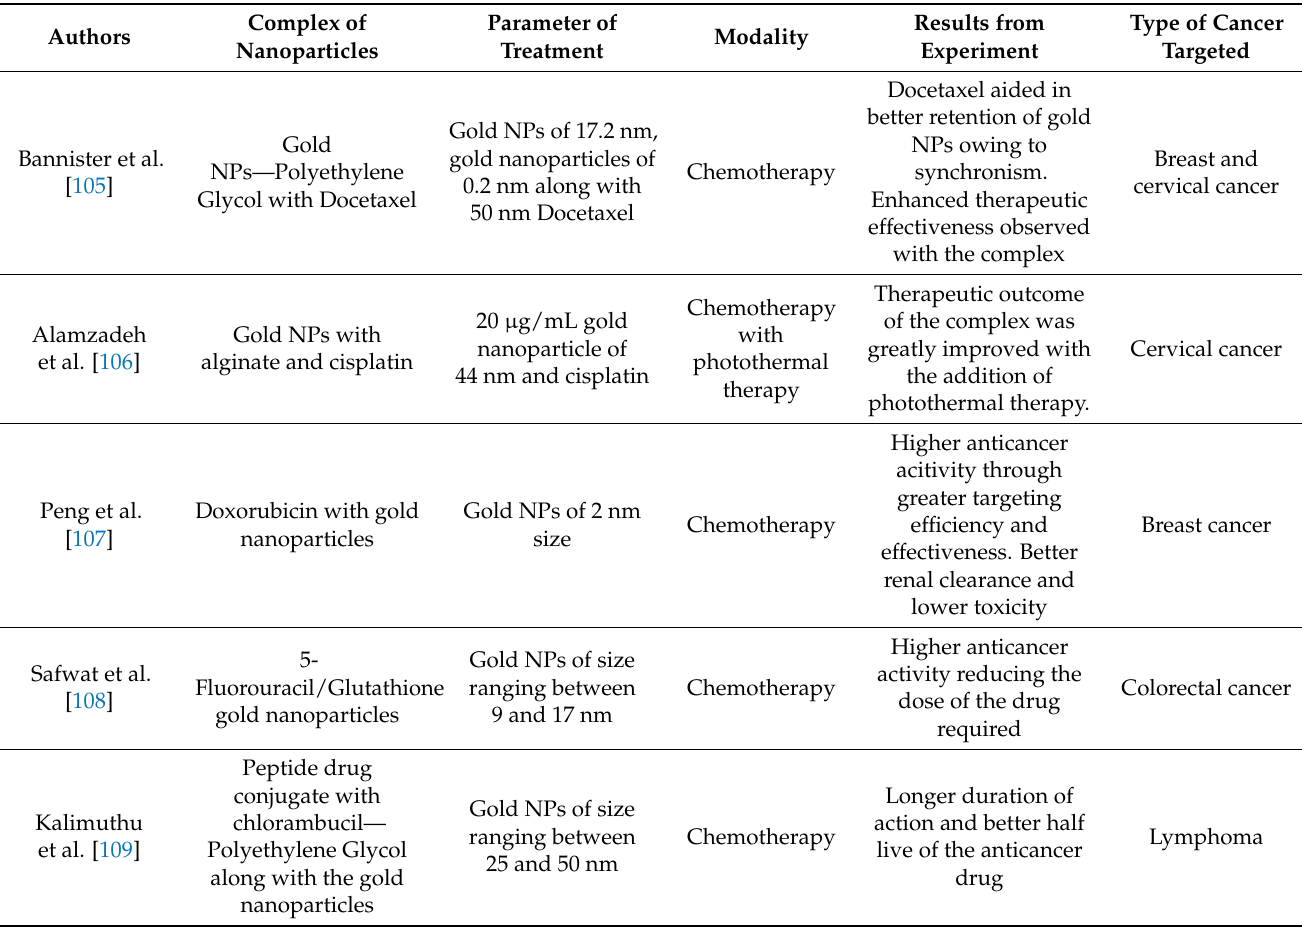
Table 3. Current implementation of anticancer medicines conjugated with gold NPs for the delivery of drugs coupled with radiation